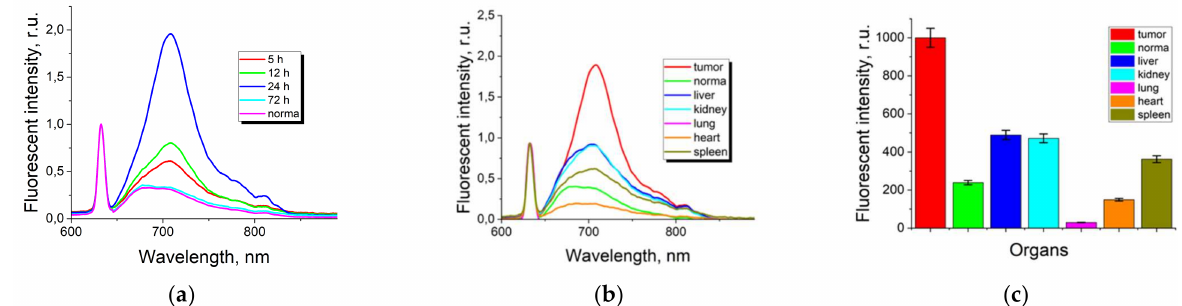
Figure 2. ( a ) Fluorescence spectra of ICG NPs colloidal solution in tumor xenografts at different times ( λ ex = 633 nm); ( b ) fluorescence spectra of ICG NPs colloidal solution in excretory organs 24 h after intravenous administration ( λ ex = 633 nm); ( c ) integral dependence of the spectral curve of ICG NPs colloidal solution in tumor xenografts under 24 h after intravenous administration ( λ ex = 633 nm).